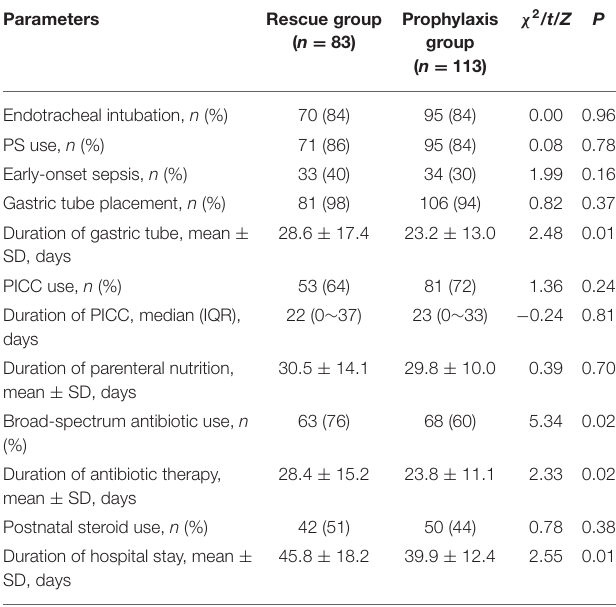
TABLE 2 | Differences in risk factors for NCFI between two groups.